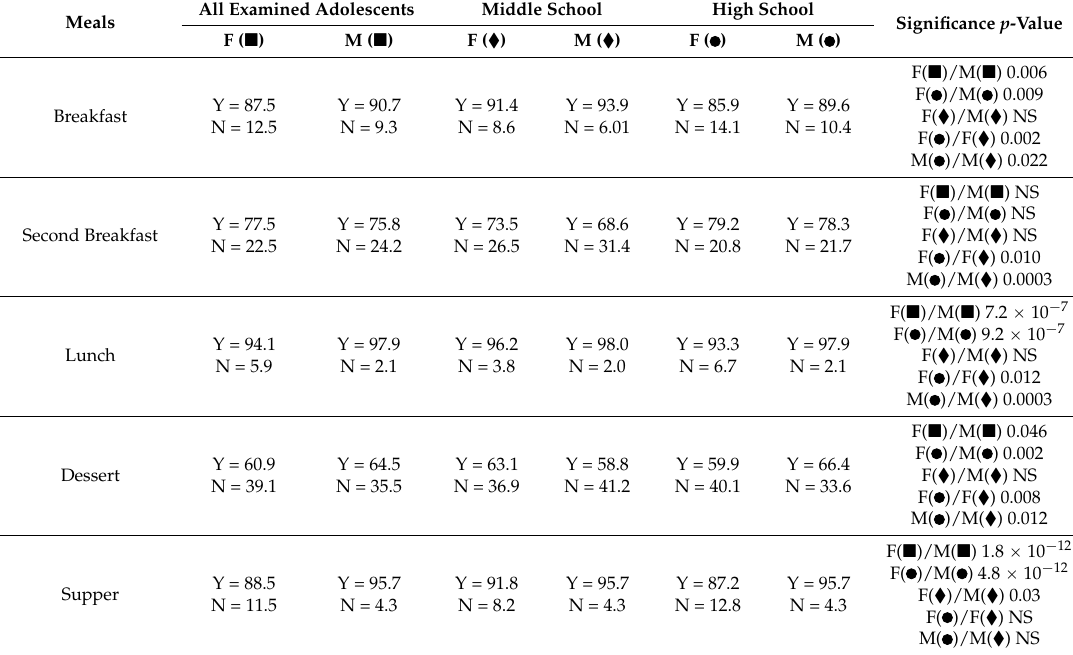
Table 3. The proportion between consumers and non-consumers of particular meals with regard to level of education.